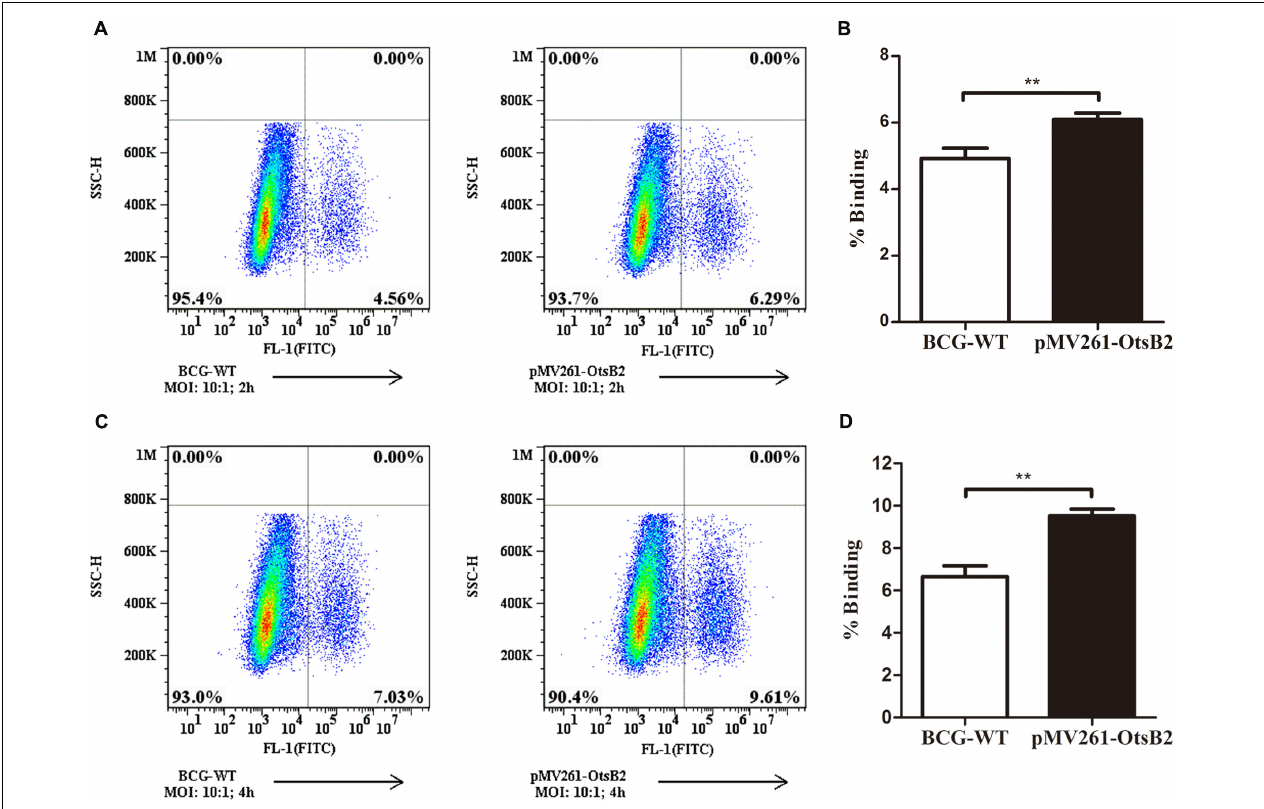
FIGURE 2 | BCG-OtsB2 has greater binding to THP-1 macrophages than WT BCG. Binding analysis of BCG-OtsB2 and BCG to THP-1 macrophages at 4 ◦ C for 2 h (A,B) and 4 h (C,D) . ∗∗ p < 0.01 by Student’s t -test. Results representative of at least three separate experiments.